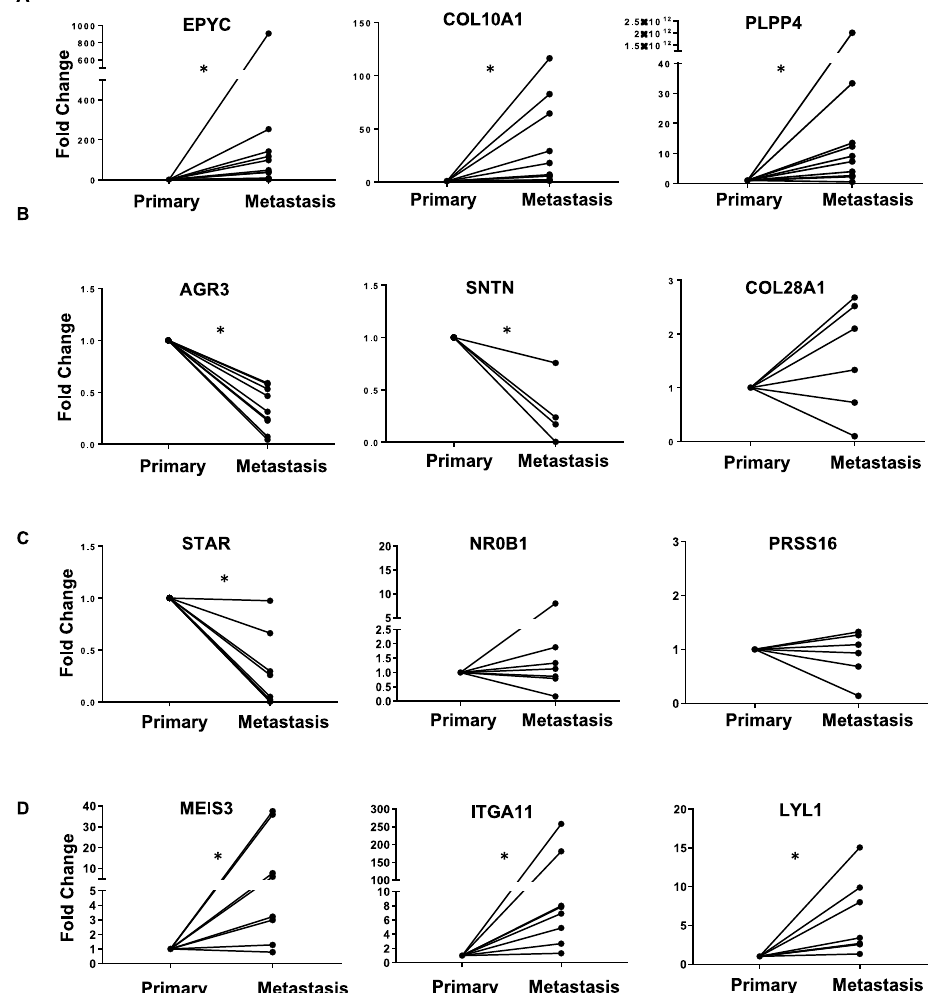
Figure 5. qRT-PCR (quantitative real-time polymerase chain reaction) validation. RNA isolated from matched primary and metastatic ovarian cancer patient tumors were used to perform qRT-PCR for the top deregulated genes in both primary and metastasis. Data represented in the form of before and after plots. ( A ) Genes upregulated in both primary and metastasis. ( B ) Genes downregulated in both primary and metastasis. ( C ) Genes downregulated in metastasis but upregulated in primary. ( D ) Genes upregulated in metastasis but downregulated in primary. * p < 0.05 (paired